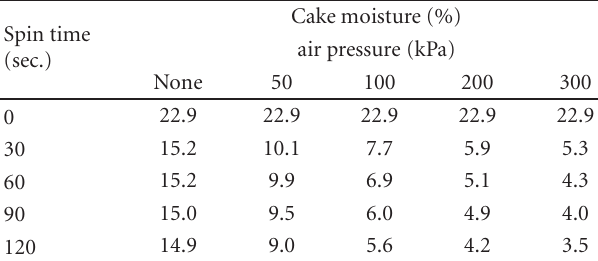
Table 4: E ff ects of G -force and air pressure on the dewatering of